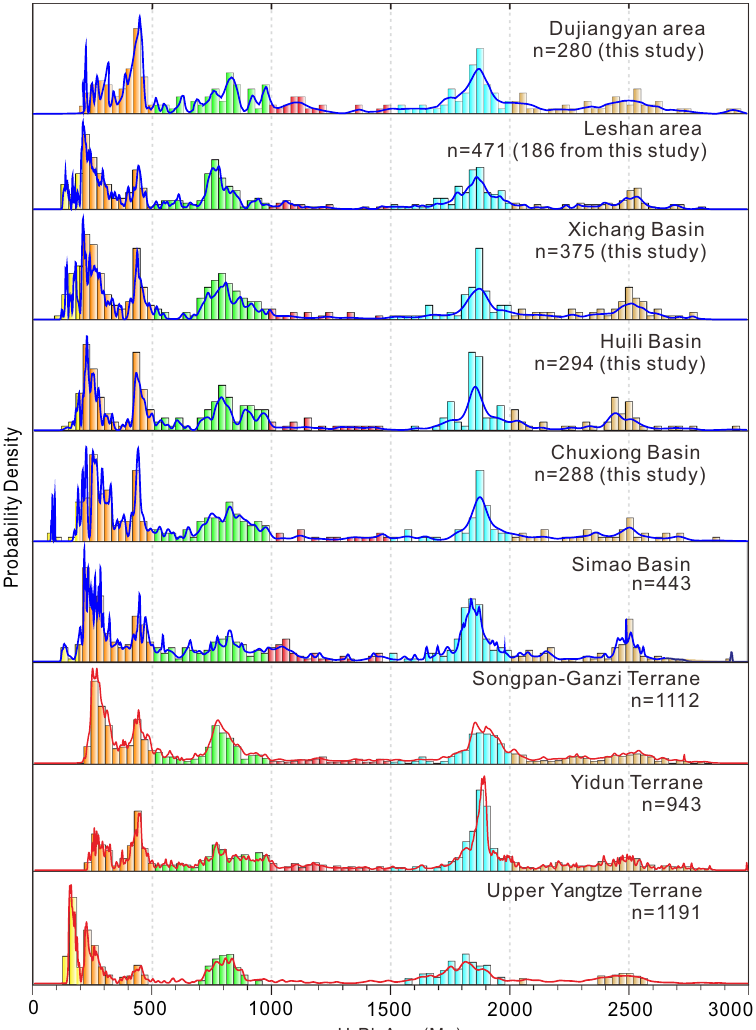
Fig. 3 Zircon U-Pb data of late Cretaceous – early Palaeogene strata and potential source regions. Zircon U-Pb data are from this study and were compiled from refs. 14,29,30,43 . Data of potential source areas are from refs. 14,30 and references therein. Blue and red lines represent normalised probability density functions of detrital zircon samples from late Cretaceous – early Palaeogene strata and potential source regions, respectively. Histograms are binned at 30 Ma intervals. n indicates number of concordant U-Pb ages. Source data information of this study is provided in Supplementary Data 1 and Supplementary Data